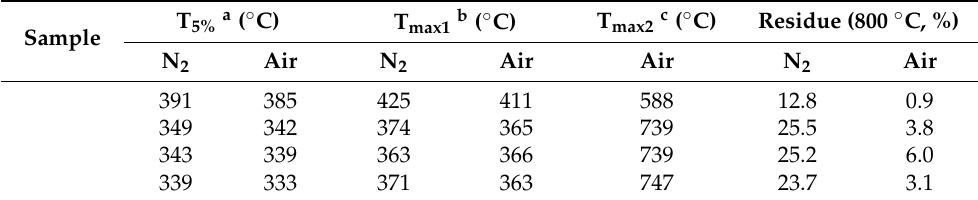
Table 1. TGA data of pure EP, EP/BP-NH 2 under N 2 and air.